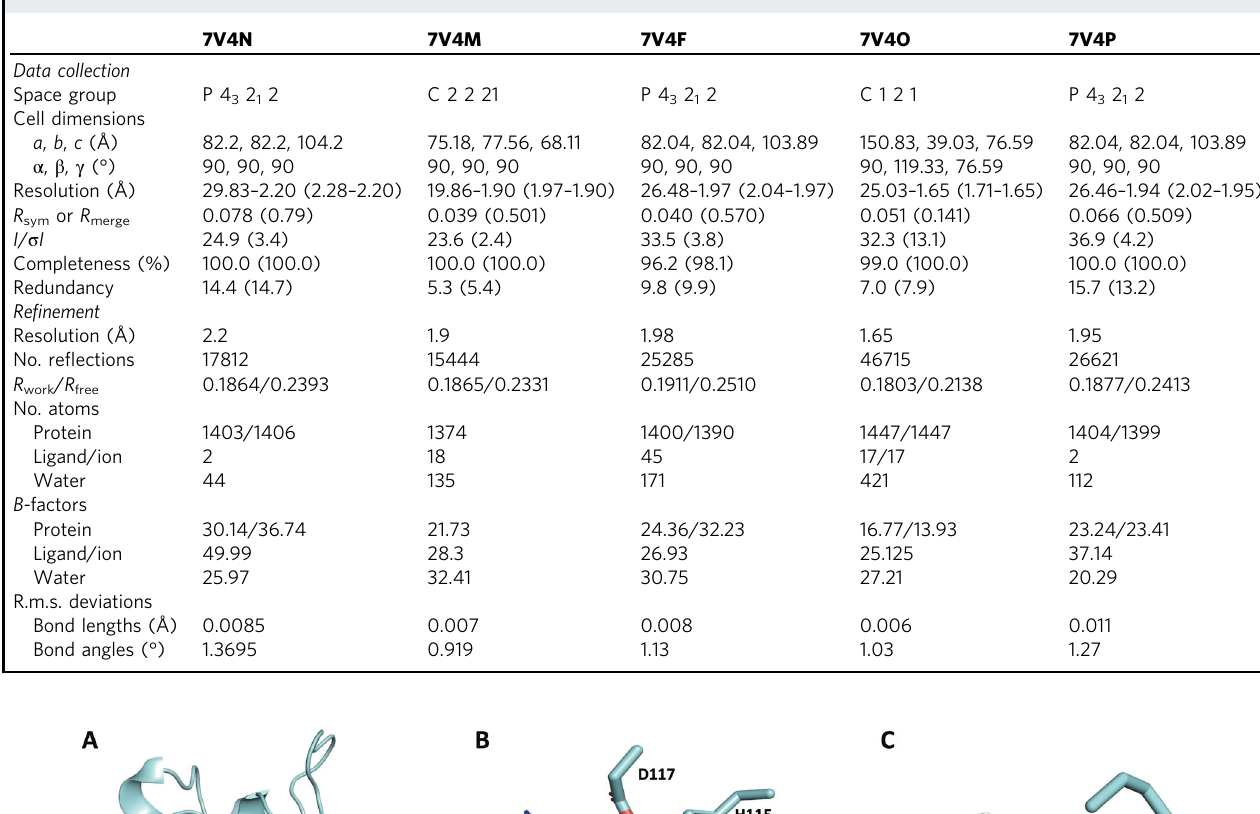
Table 1 Data collection and re fi nement statistics (molecular replacement).